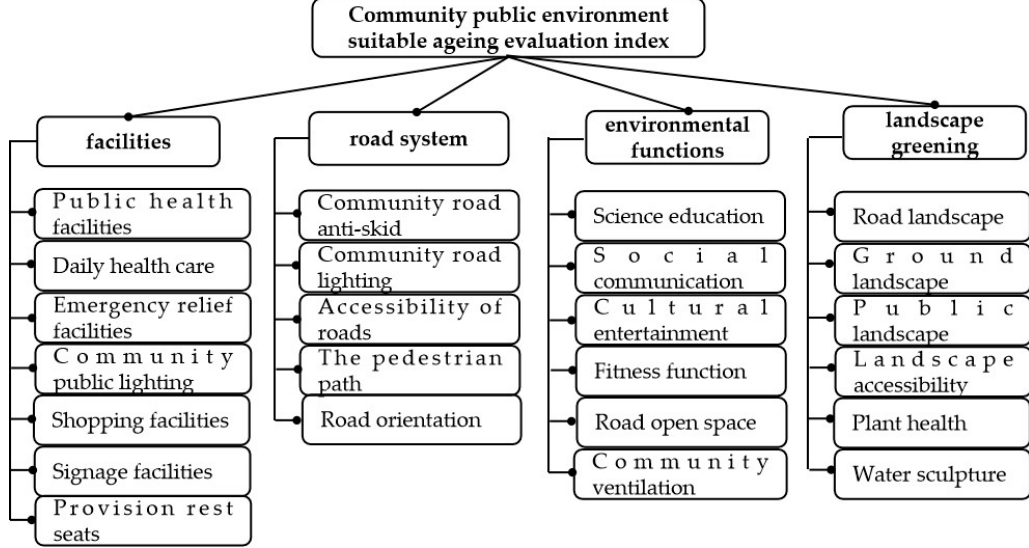
Figure 1. Aging-friendly community public environment suitable evaluation index.